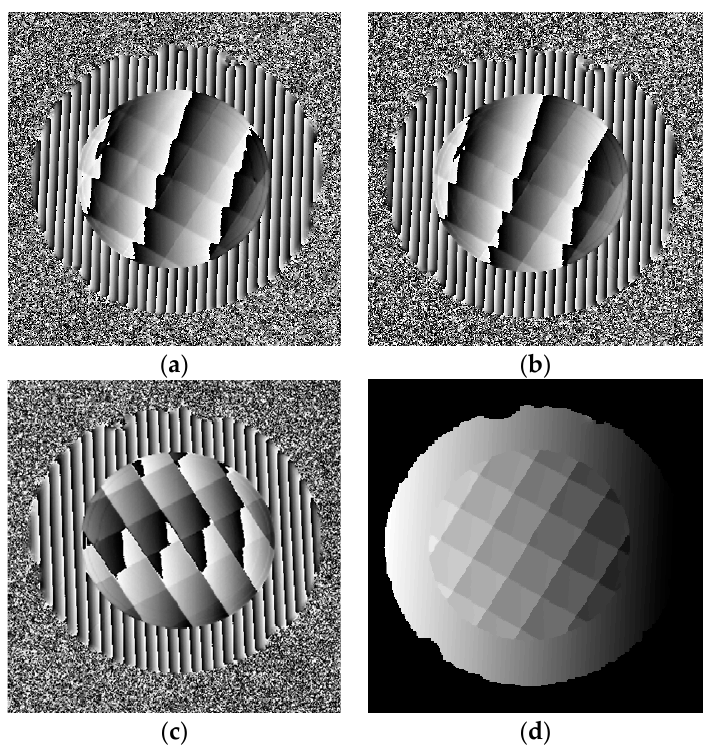
Figure 10. Phase maps of the reflected diamond distribution surface object. ( a – c ) are three wrapped phase maps having fringe numbers of 100, 99 and 90, ( d ) is the absolute phase map.